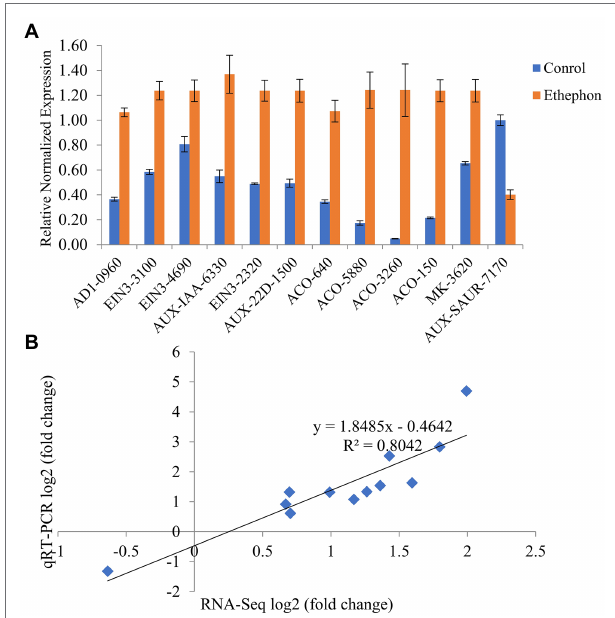
FIGURE 6 | Quantitative real-time PCR (qRT-PCR) verification. (A) Relative expression levels of 12 selected DEGs between ethephon-treated and control plants. Error bars indicate the SEs. (B) Correlation analysis of RNA-seq log2 (fold change) and qRT-PCR log2 (fold change) of 12 selected genes: AD1- 0960 (CmoCh09G010960.1), ETHYLENE INSENSITIVE 3 (EIN3)-3100 (CmoCh05G013100.1), EIN3-4690 (CmoCh09G004690.1), AUX-IAA-6330 (CmoCh10G006330.1), EIN3-2320 (CmoCh12G012320.1), AUX-22D-1500 (CmoCh15G011500.1), AUX-SAUR-7170 (CmoCh19G007170.1), ACO-640 (CmoCh02G000640.1), ACO-5880 (CmoCh03G005880.1), ACO-3260 (CmoCh07G003260.1), ACO-150 (CmoCh11G020150.1), and MK-3620 (CmoCh16G003620.1).